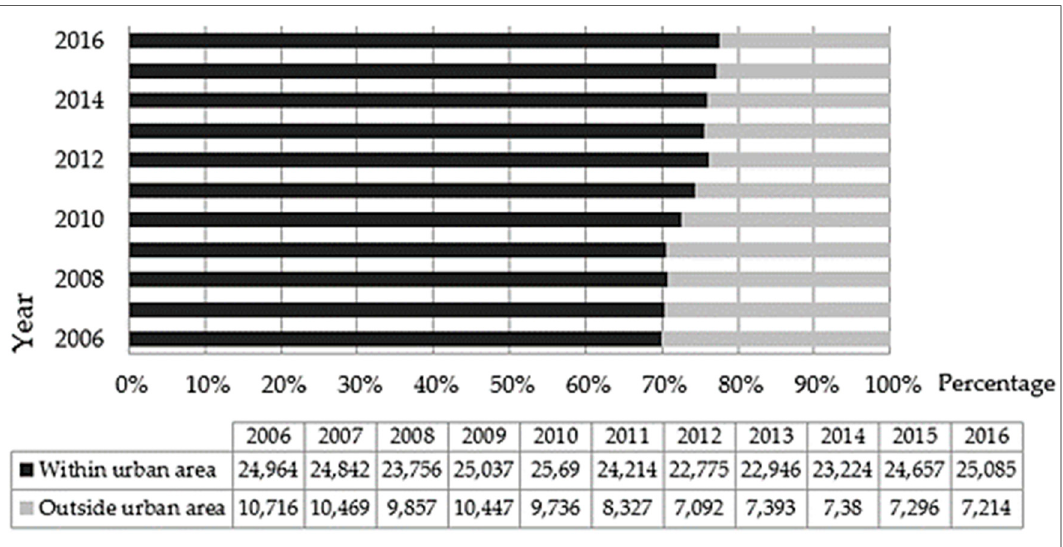
Figure 1. Percentage of crashes with casualties by location between 2006 and 2016 in Portugal [2] .